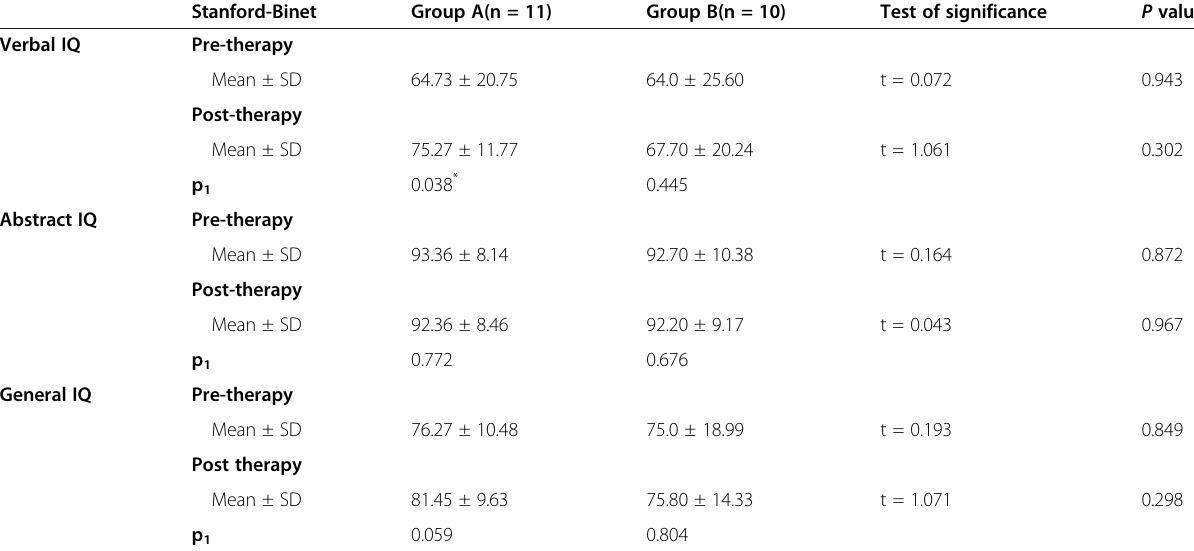
Table 2 Comparison between the two studied groups according to Stanford-Binet Scale